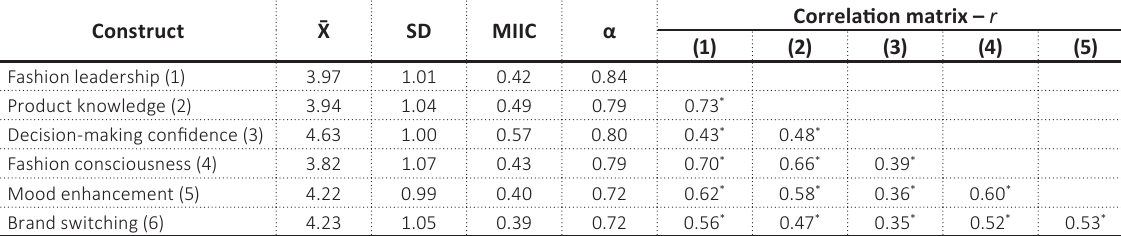
Table 2. Descriptive statistics, reliability and validity measures, and correlation matrix